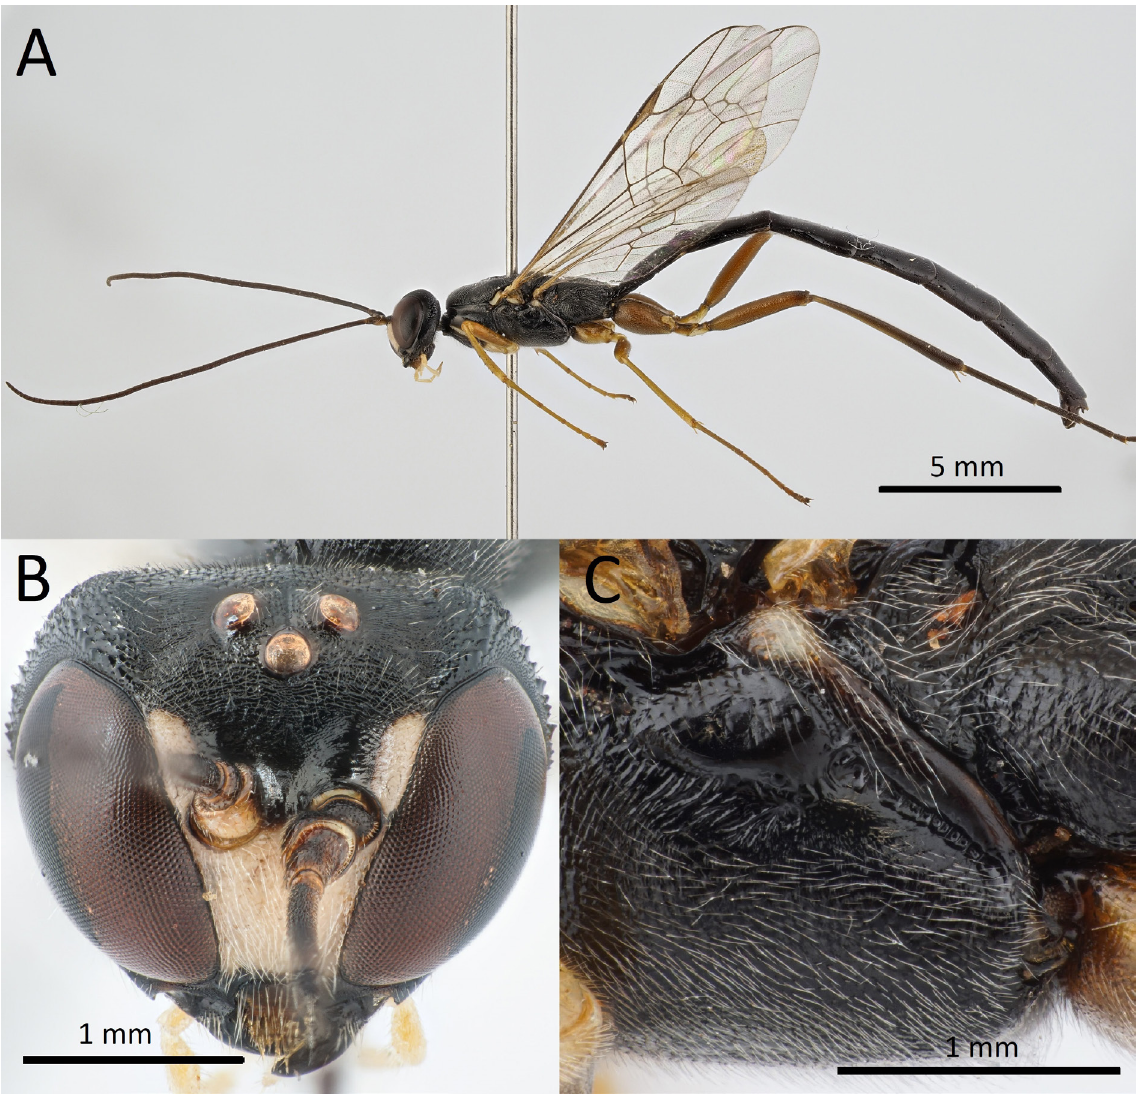
Fig. 1. Neoxorides striatus Johansson sp. nov., holotype ♂ (BC ZSM HYM07485). A . Habitus, lateral view. B . Head, anterior view. C . Mesopleuron, lateral view. Photos: Stefan